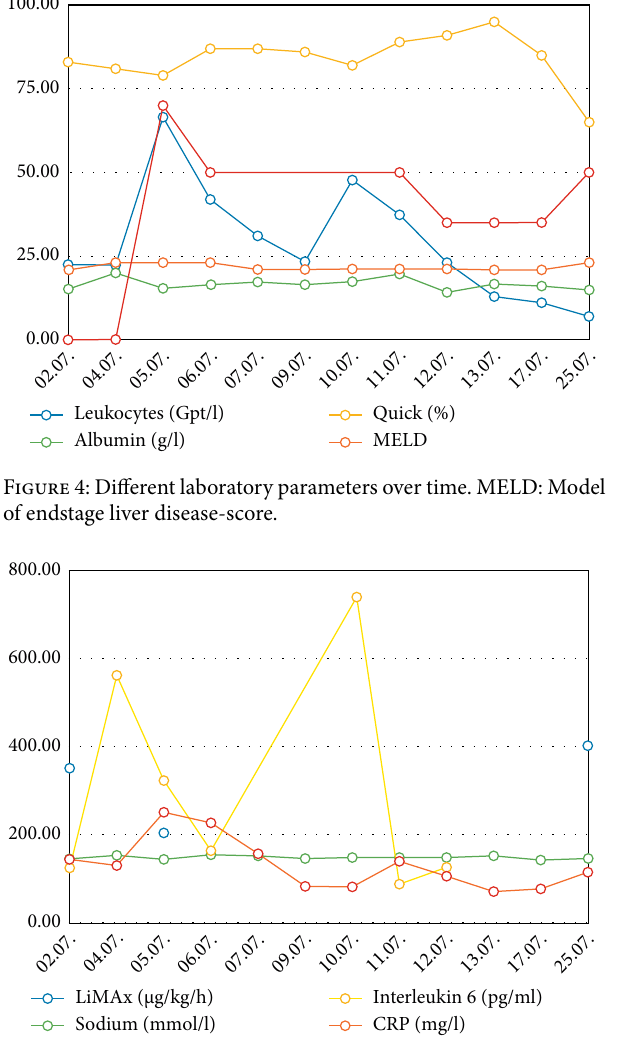
Figure 5: Various laboratory parameters and LiMAx measured values over time. CRP: C-reactive protein.